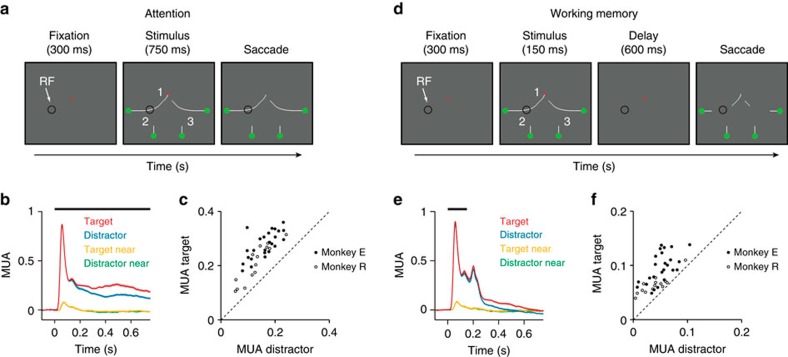
The influence of attention and working memory on spiking activity.(a,d) After a 300 ms fixation period, four curves appeared on the screen. The monkeys had to make a saccade to a green circle at the end of the target curve connected to the fixation point. In the attention task (a) the stimulus remained on the screen whereas the stimulus disappeared after 150 ms in the memory task (d). After an additional delay (600 ms), part of the stimulus reappeared, but the segments at locations 2 and 3 did not, so that the animal had to remember the configuration of the target curve. Black circle, typical RF location. (b,e) Neuronal activity averaged across all V1 recording sites in the attention (b) and the memory task (e). The RF fell on the target (red trace), distractor curve (blue), or next to the target (yellow) or distractor curve (green). Shaded areas show s.e.m. (n=37 penetrations; when they are difficult to see the s.e.m. is small). (c,f) Data of the individual penetrations in monkeys E (black data points) and R (white) in the attention (c) and working memory task (f). Abscissa, MUA elicited by the distractor curve (200–750 ms after stimulus onset). Ordinate, MUA elicited by the target curve.